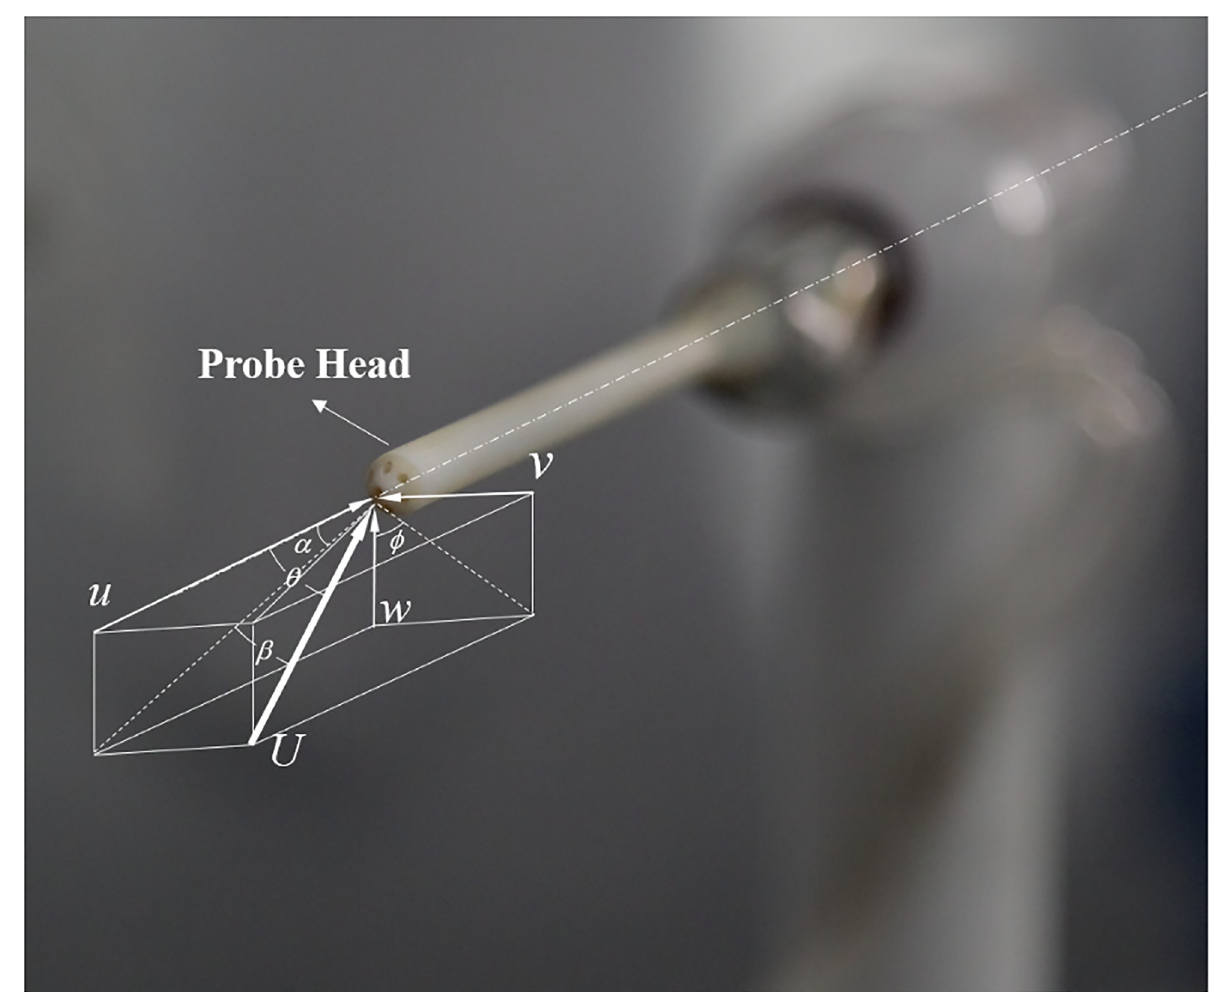
Fig 2. The body-coordinate system of probe and flow angles